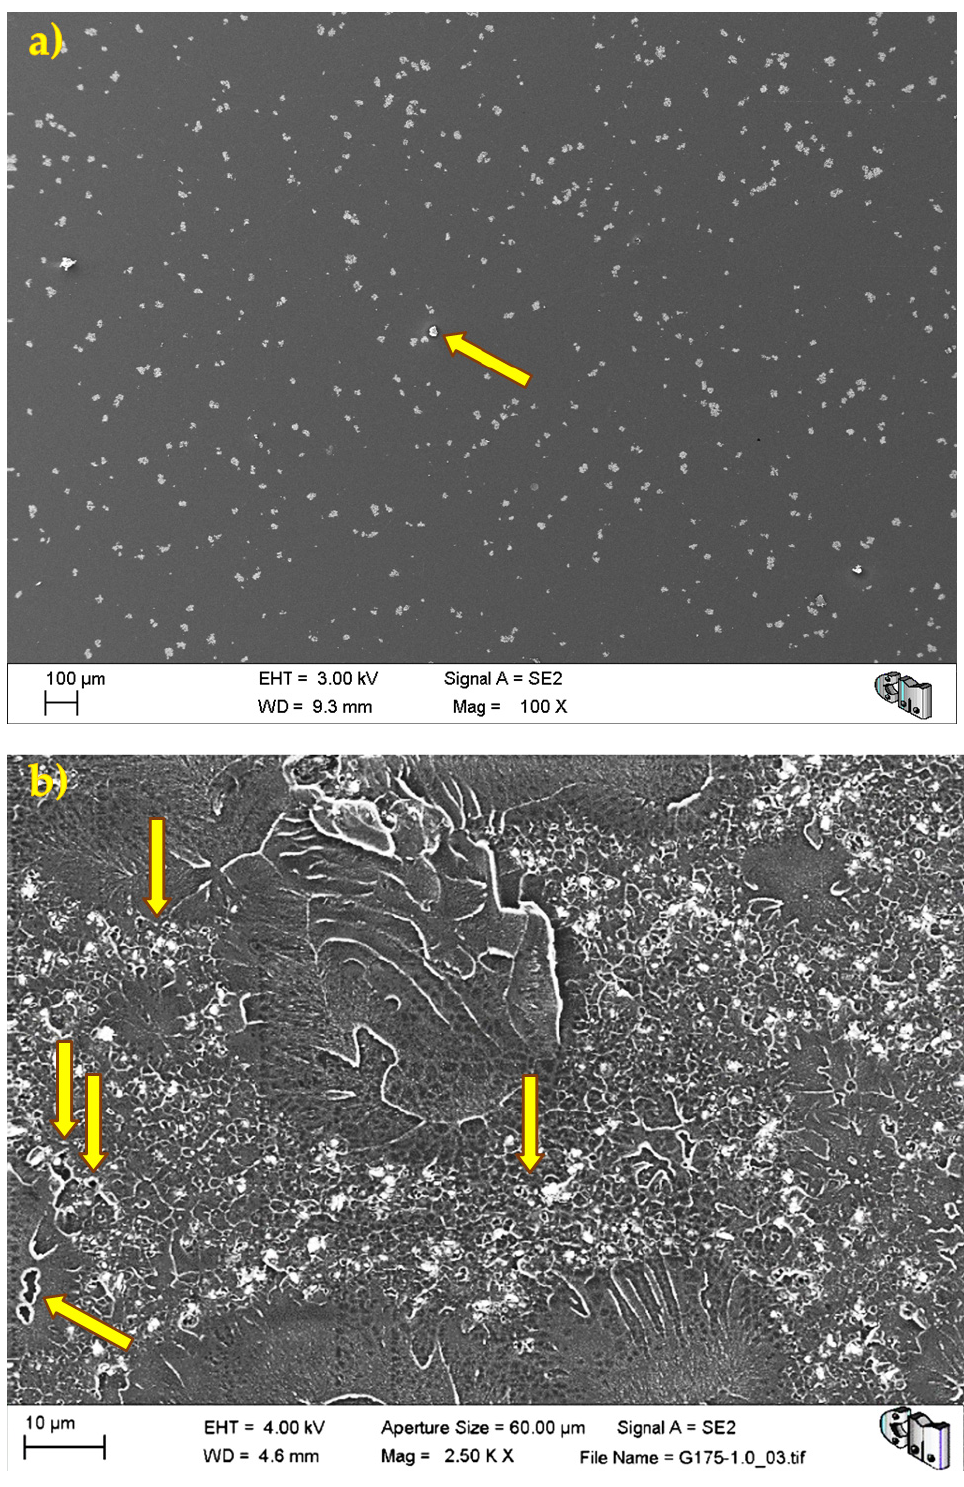
Figure 4. Microstructure of G120-0.1: ( a ) at low magnification, the barium sulphate radiopacifier appears as a uniformly dispersed white contrast in the PMMA matrix; and ( b ) at higher magnification, some tiny pores and defects can be observed.